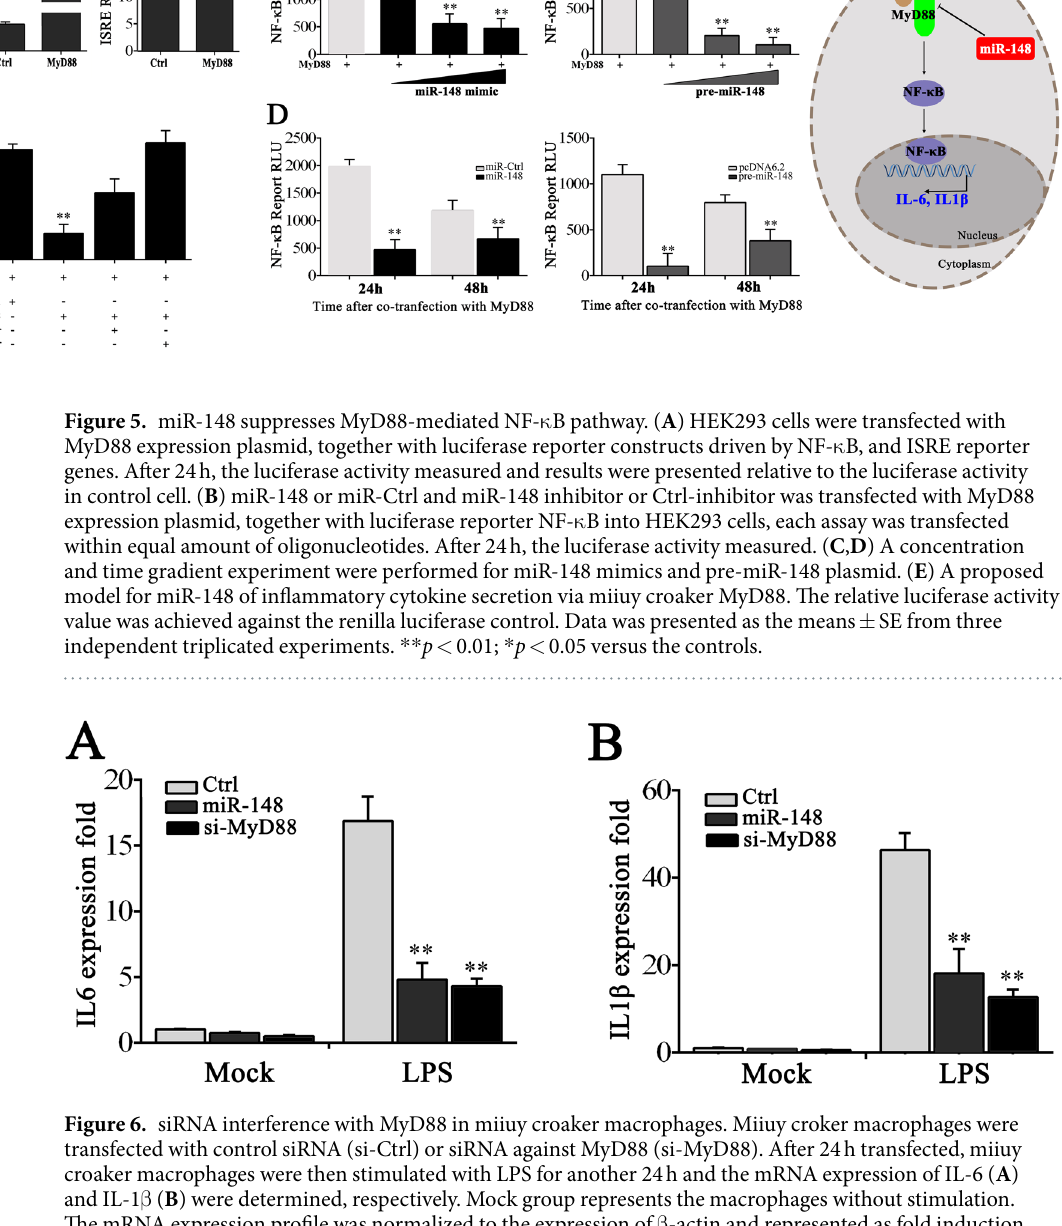
excessive inflammatory may disrupt immune homeostasis, leading to some diseases and even death. Thus, mech- anisms for the negative regulation of immune response are especially important. Upon recognition of PAMPs, almost all TLRs bind MyD88 leading to the transcription of inflammatory cytokines and then transcriptionally regulate host-cell response to pathogens 22 . MyD88 is a key downstream adaptor for most Toll-like receptors and interleukin-1 receptors 23 . Recently studies demonstrated that the struc- ture of MyD88 is well conserved and its homolog in fish species may function similarly to the mammalian coun- terparts 24 . Until now, an array of miRNAs has been indicated to regulate MyD88 in mammal, including miR-155, miR-149 and miR-203 25 . In lower vertebrates like fish, few evidences exist to support the direct regulation of MyD88. Recently, we first discover that miR-3570 is responsible for the inflammatory reaction by targeting MyD88 after Vibrio anguillarum infection, which suggest the mechanism for miRNA regulation in teleost fish, as